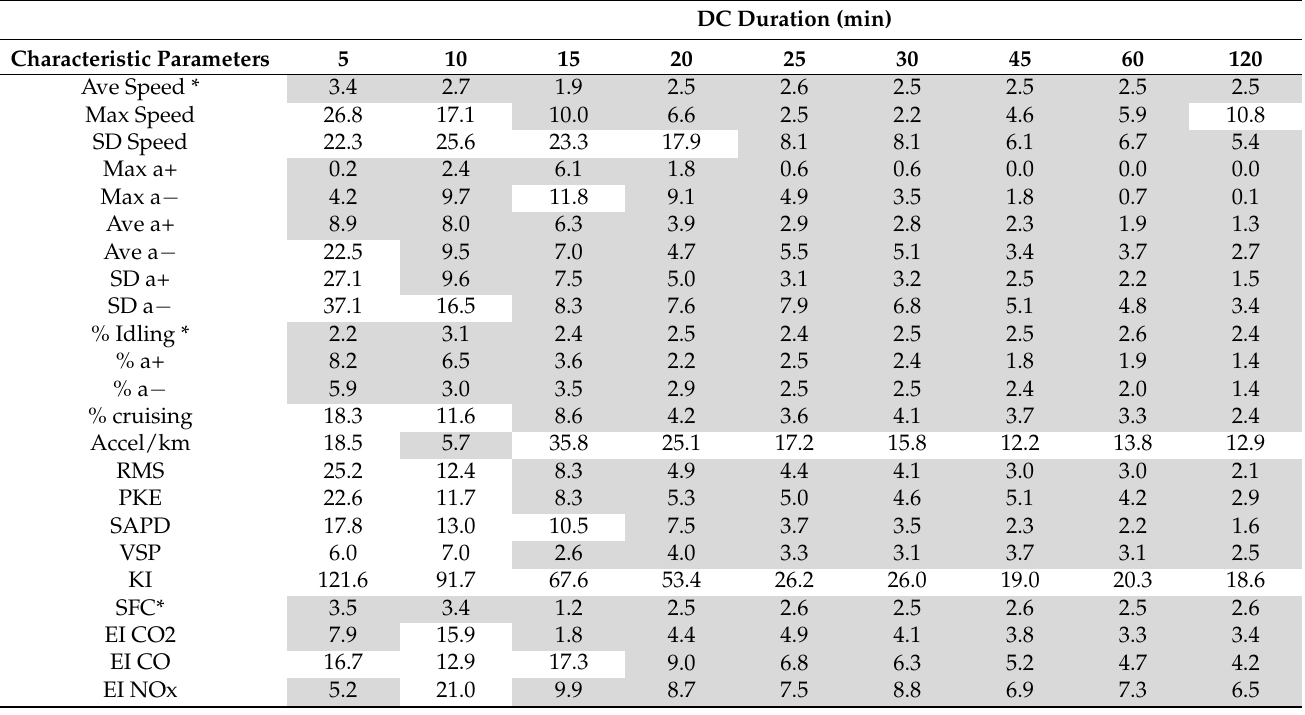
Table 2. MRD i of 500 DCs obtained by the micro-trip method using the same trip database for the case of the Urban 1 region. DC Duration (min)